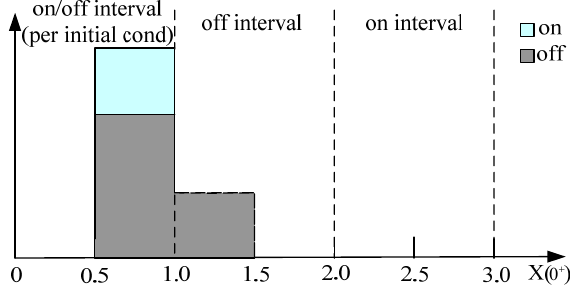
Figure 3. The state distribution of ACs instantly after the temperature set point step